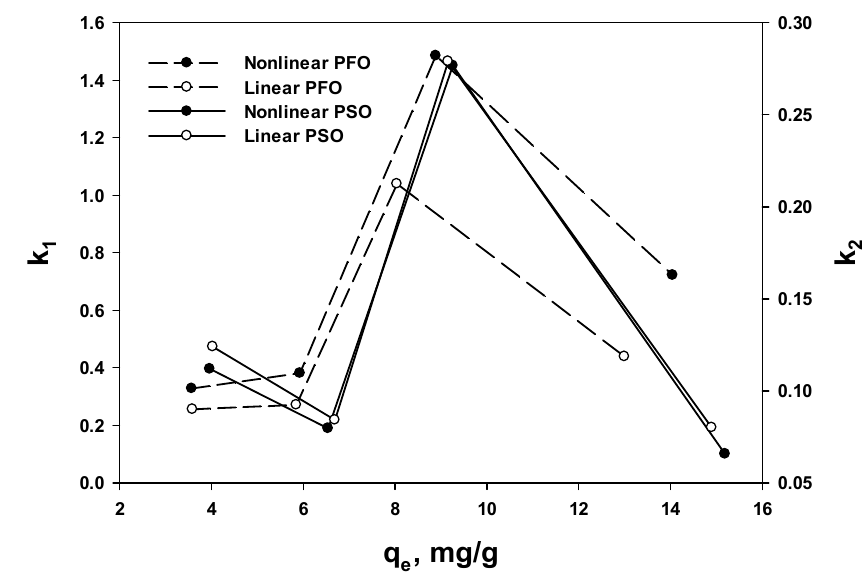
Figure 6. Plots of the adsorbed amount ( q e ) vs. rate constants k 1 and k 2 .